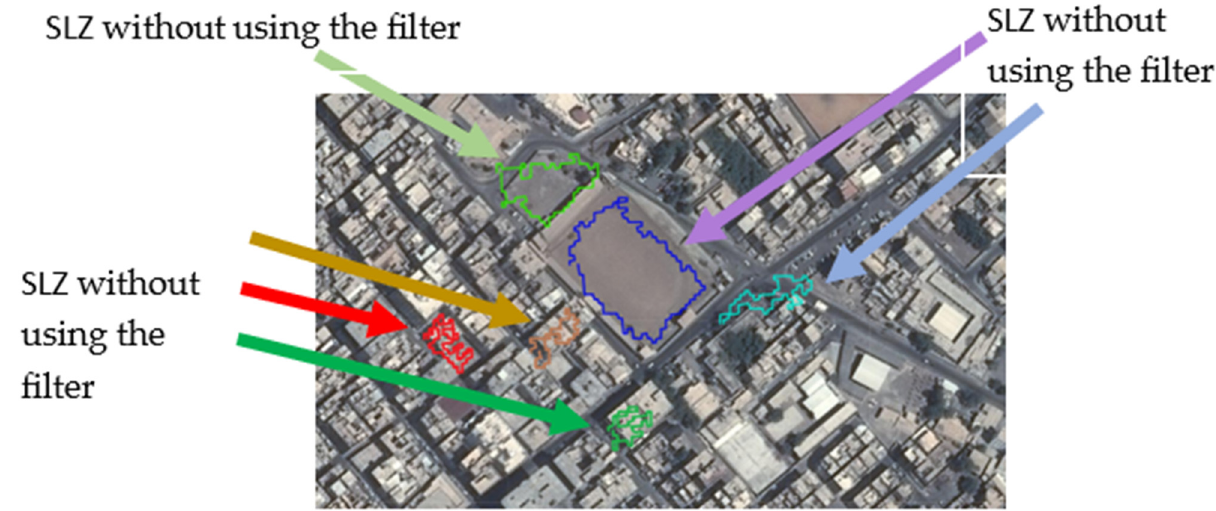
Figure 11. SLZs of parts of Scene 1 projected on the aerial map without using the filter.